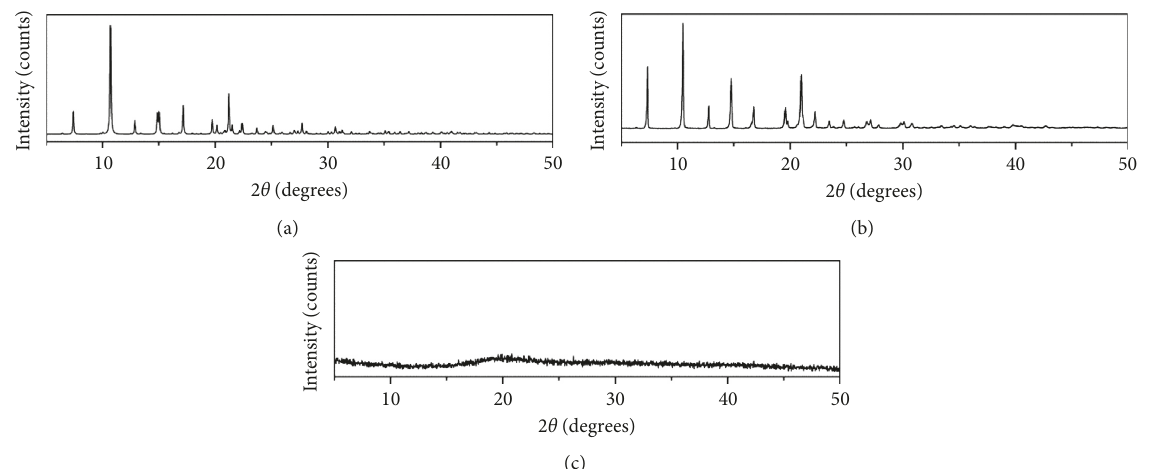
Figure 5: Diffractograms of the complexes: (a) simulated for LISZn2, (b) experimental for LISZn2, and (c) experimental for LISZn1.